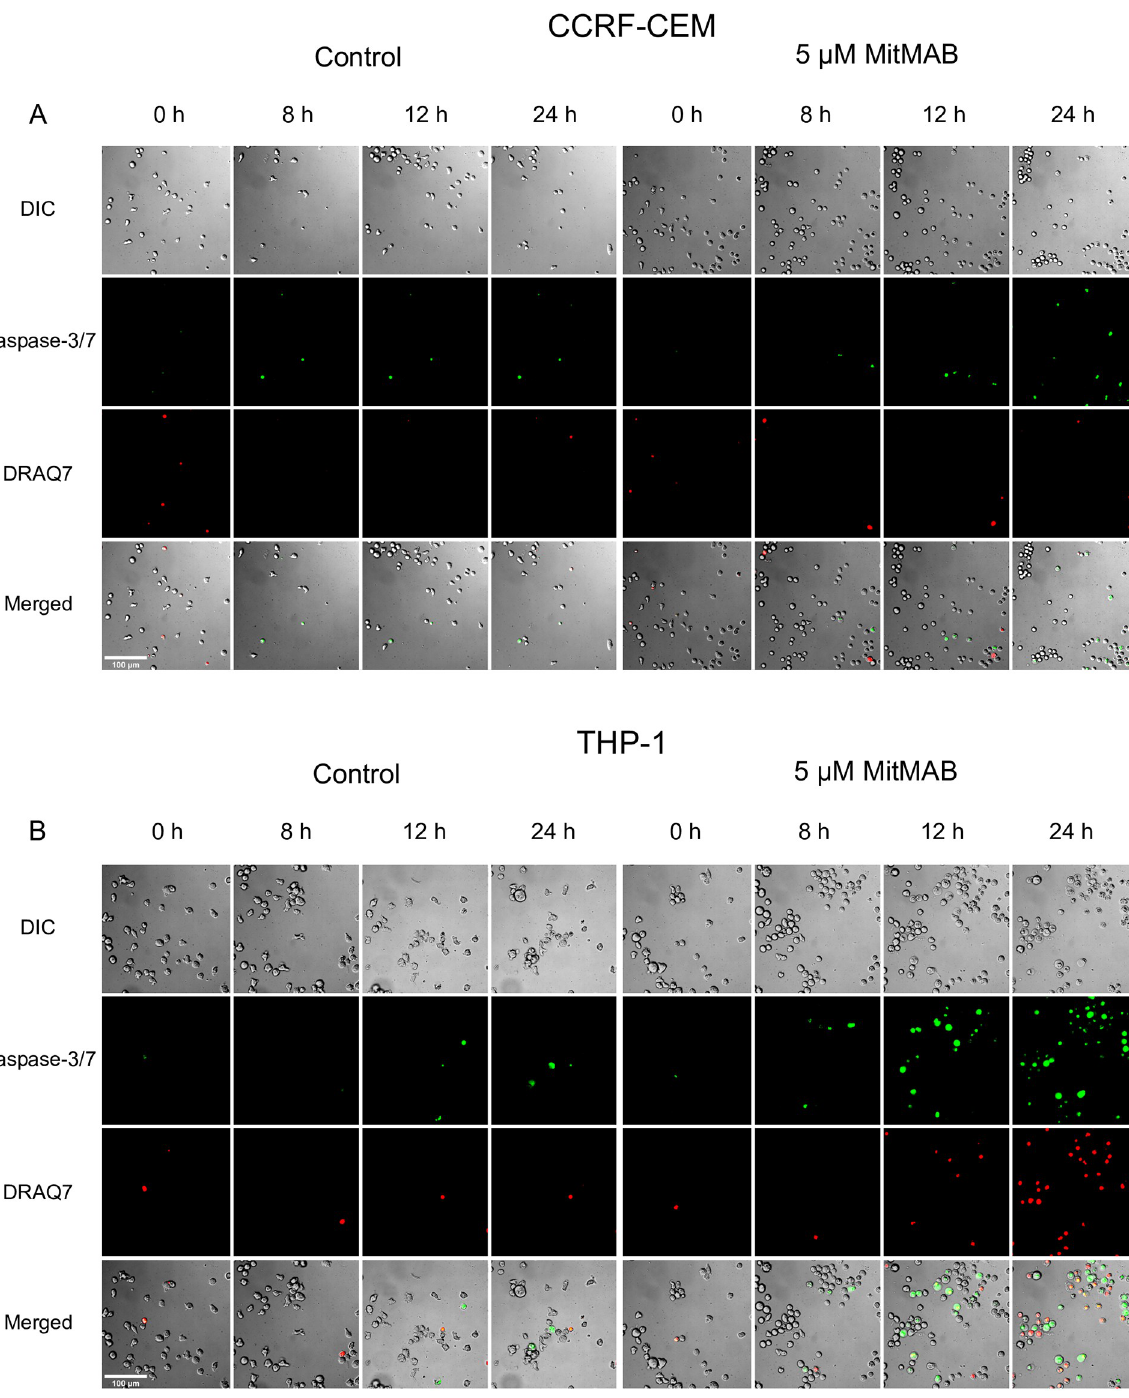
PLOS ONE | https://doi.org/10.1371/journal.pone.0256708 September 7,